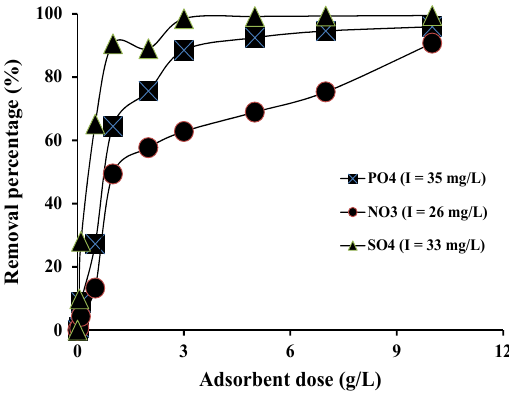
Figure 3. Effect of Dowex 21K XLT resin dose on the percentage removal of phosphate, nitrate and sulphate from MBR treated solution (I is initial concentration).